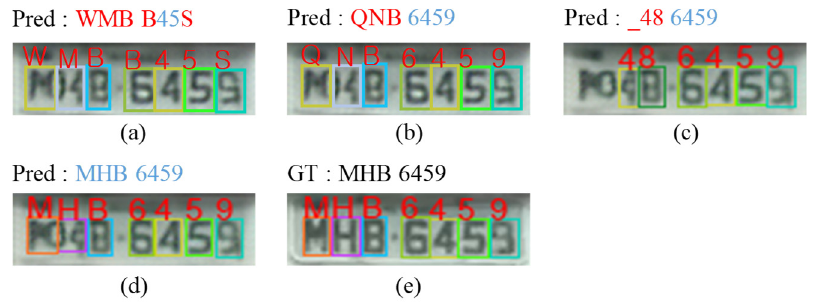
Table 6. Comparison between the LP recognition module based on high-frequency augmentation and other modules for scale factor ( × 4) on the UFPR dataset.